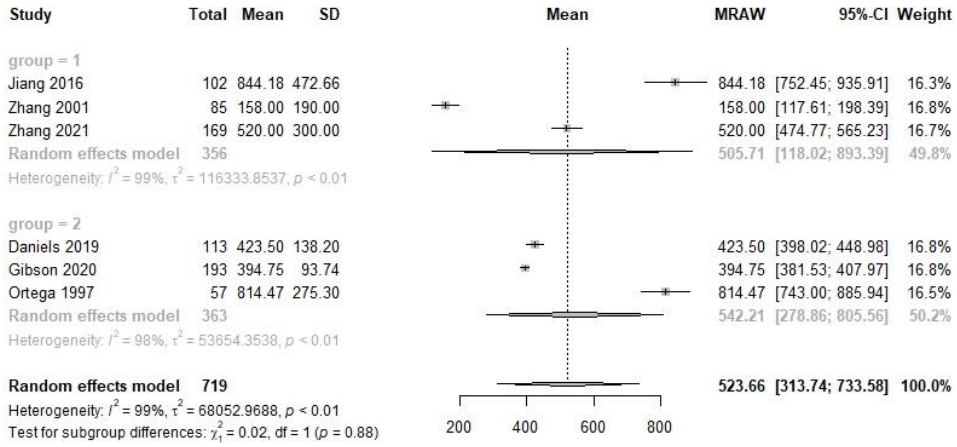
Figure 3. Forest plot of transitional human milk VA concentration and subgroup analysis between Chinese and non-Chinese samples.